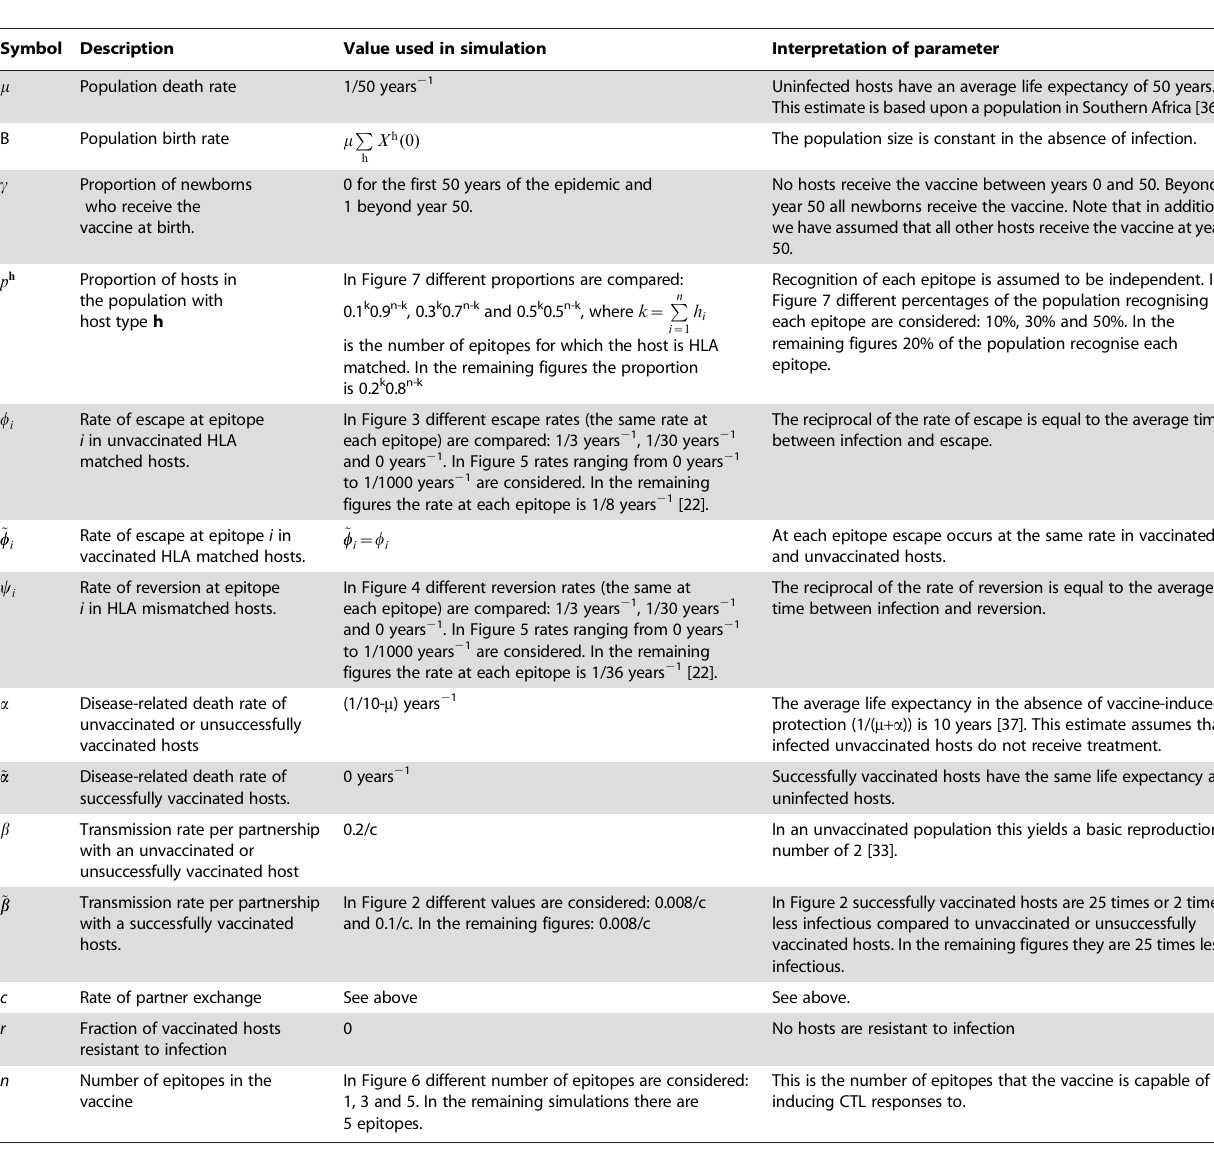
Table 2. Definitions of the model parameters and a description of the parameter values used in our simulations.